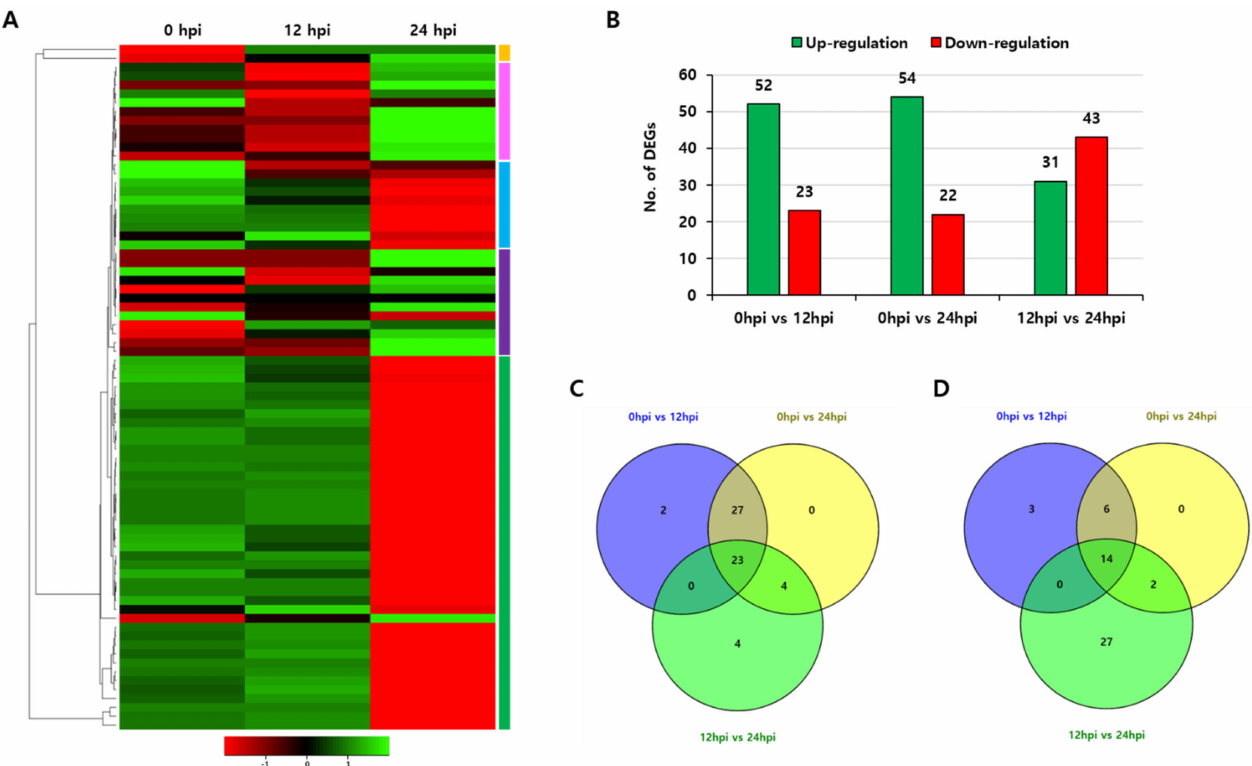
Figure 6. Expression patterns of 77 rice U-box gene family members in indica rice plants infected with Magnaporthe oryzae . ( A ) Heatmap showing expression of total differential expressed genes with increased or decreased trend. ( B ) Total number of upregulated and downregulated genes. ( C ) Venn diagram of upregulated genes in the two samples vs. control. ( D ) Venn diagram of downregulated genes in the two samples vs. control. Two samples are 12 hpi and 24